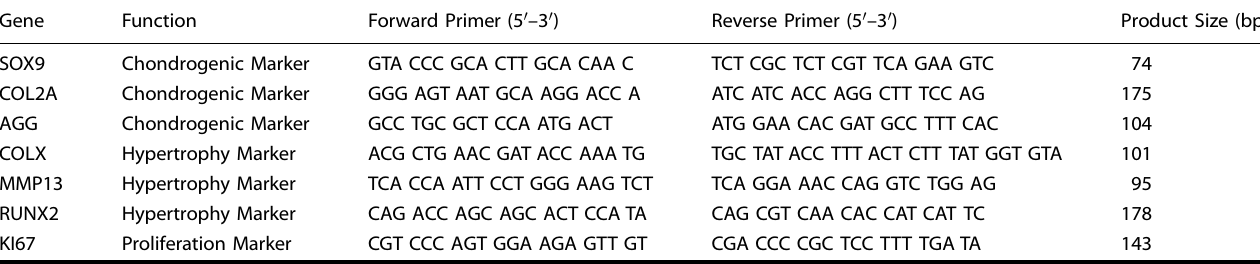
List of primer pairs for the analysis of chondrogenesis and hypertrophy in ASCs and DCs.